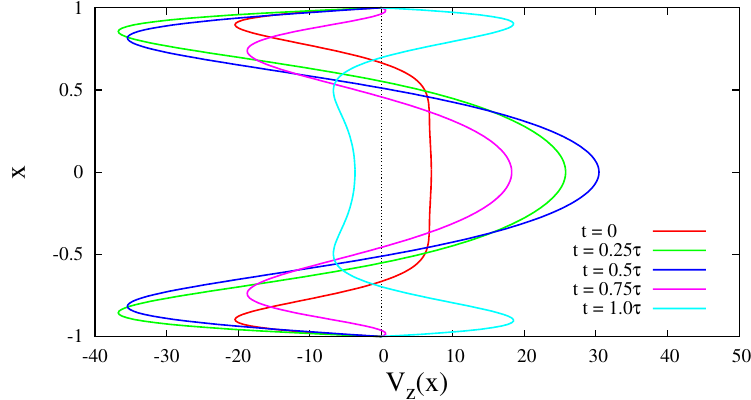
Figure 2. Velocity profile for non-stationary thermovibrational fluid flow induced by the internal heat generation at different moments in time over a half-period of vibrations τ . Parameters are set to A = 100, Gr Q = 10, Pr = 20, Ω = 100. The half-period of vibrations is equal to τ = π